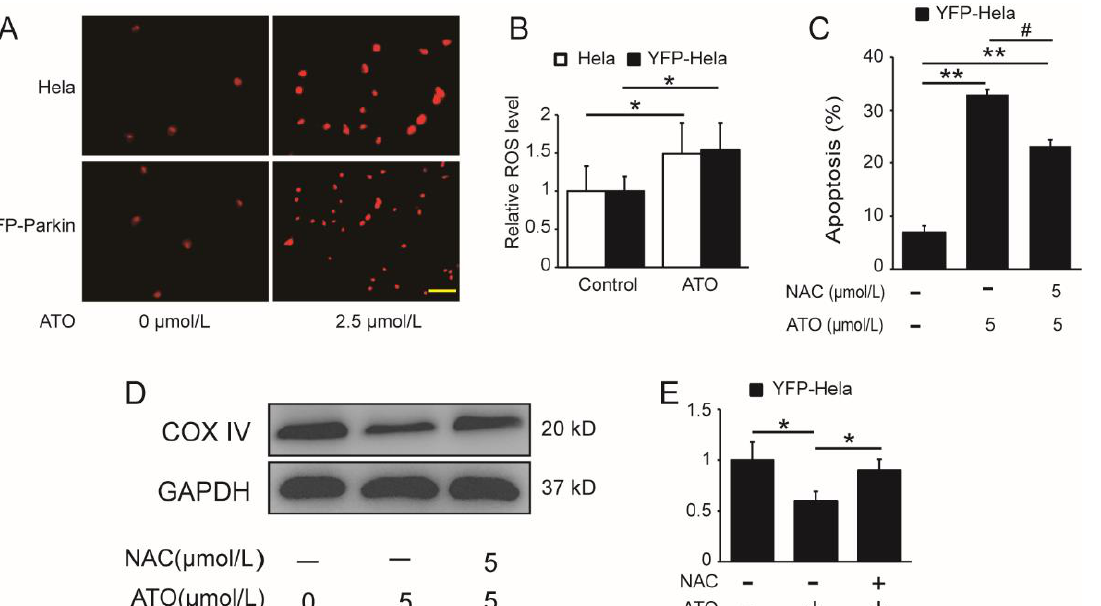
Figure 5. Potentiating effect of ATO on ROS production. ( A ) Red fluorescence indicates the produc- tion of ROS after cell treatment for 6 h, and the images were analyzed using a fluorescence micros- copy. Scale bar, 10 µm. ( B ) shows the quantification of the red fluorescence, which was performed using Image J software. ( C ) YFP-Parkin HeLa cells were treated with the indicated concentrations of ATO for 24 h before detection of cell apoptosis by flow cytometry. ( D ) Western blot analysis of COX IV expression rescued after ATO treatment for 24 h in YFP-Parkin HeLa cells. ( E ) Quantifica- tion of D. ( F ) YFP-Parkin HeLa cells were fixed and immunostained for nuclei (blue) and mitochon- dria (red) after ATO treatment for 24 h. The red fluorescence indicated the normal mitochondrial membrane potential. The green fluorescence was the marker of YFP-Parkin proteins. The level of mitophagy was evaluated by the number of green puncta. The samples were analyzed using a flu- orescence microscopy. Scale bar, 10 µm. ( G ) Quantification of the red fluorescence, which was per- formed using Image J software. ( H ) Quantification of the green fluorescence, which was performed